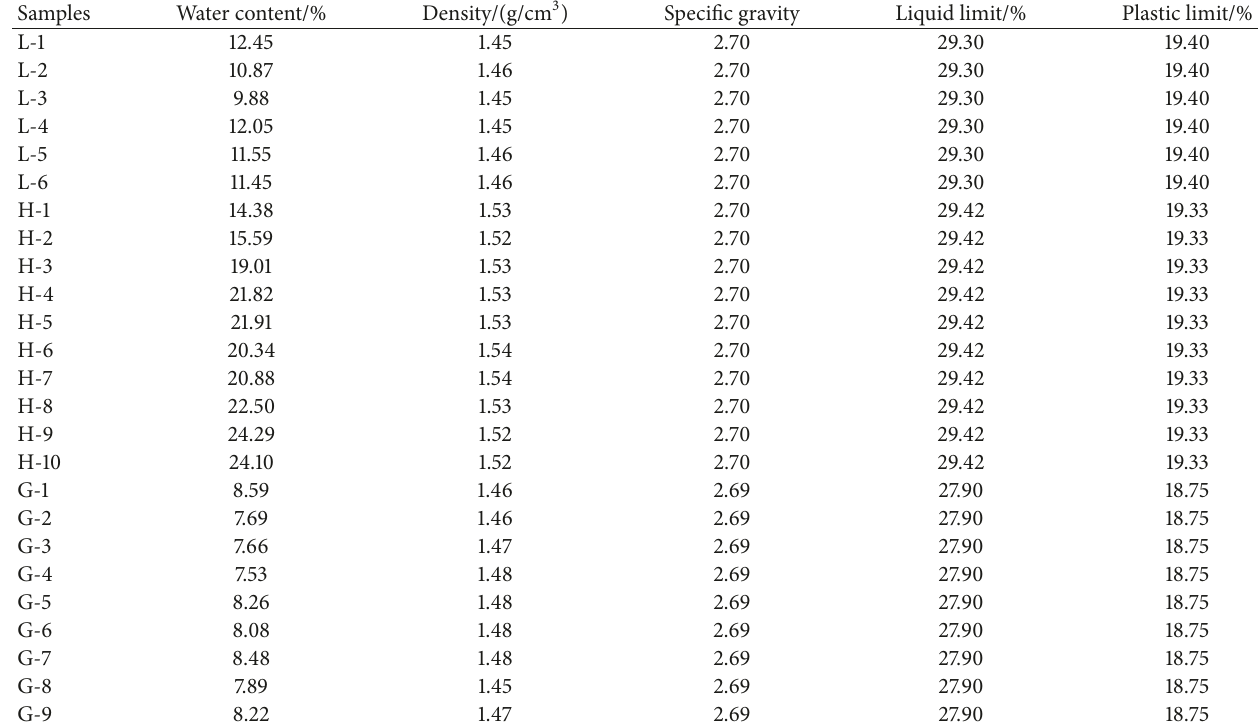
Table 1: Physical property indexes of test